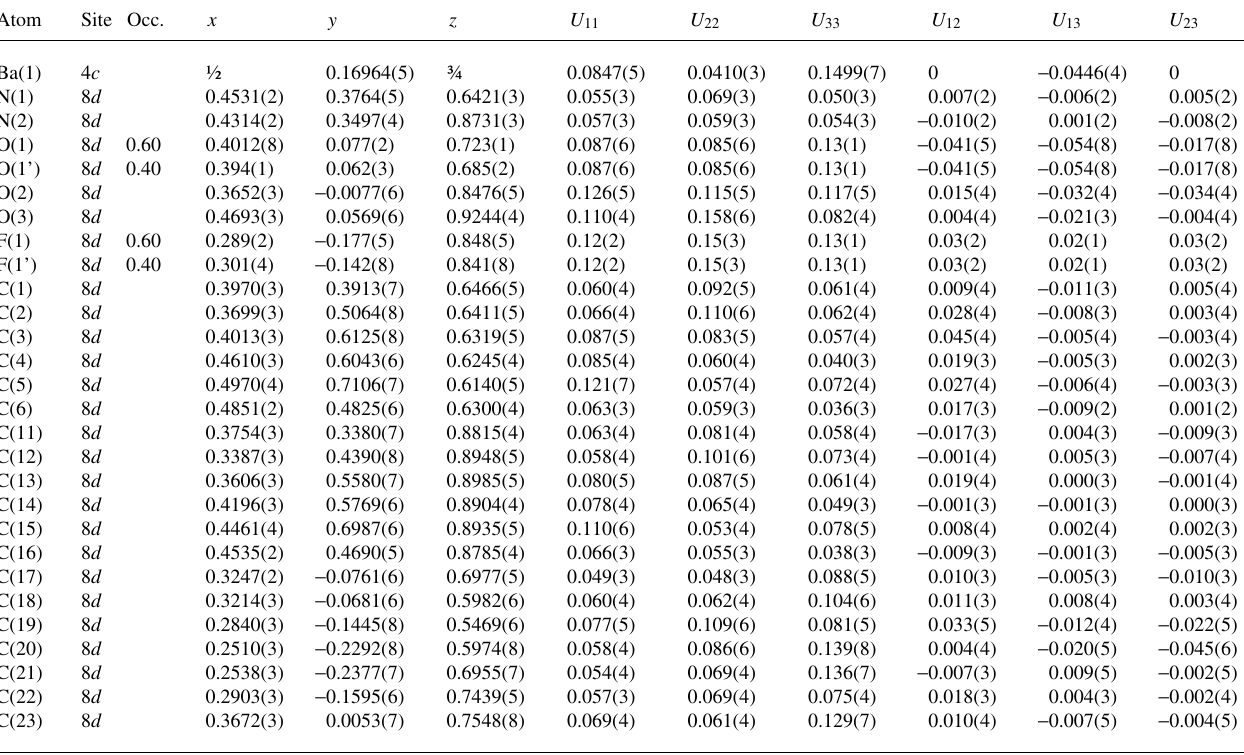
Table 3. Atomic coordinates and displacement parameters (in Å 2 )